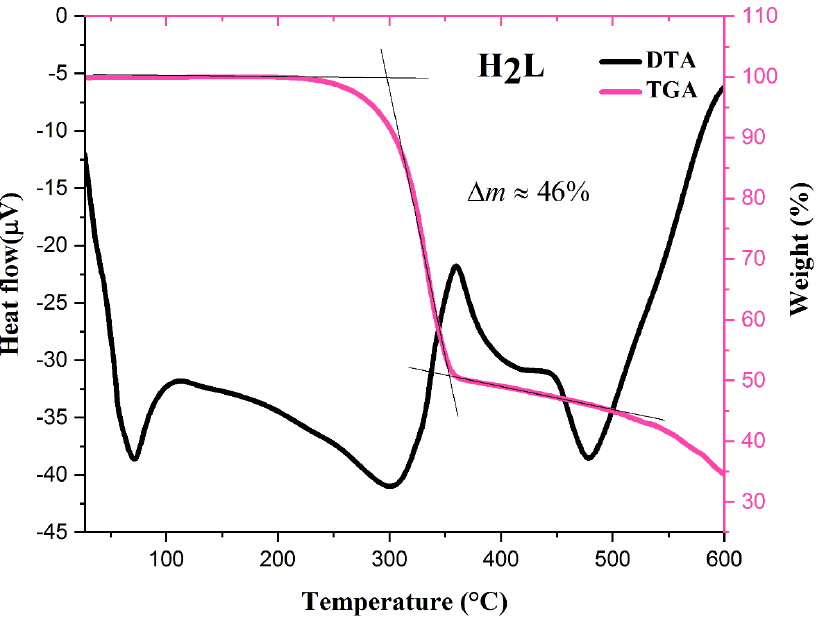
Figure 6. TGA and DTA of the free ligand H 2 L.